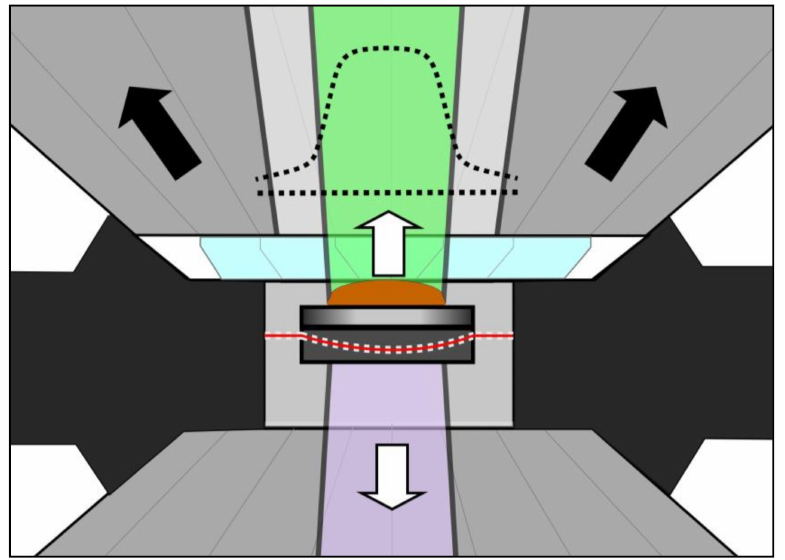
Figure 5. Schematic of dynamic compression in an LDC–DAC with internal target (See Figure 2B), showing an impinging laser beam (green) on a target (graded plate). The target is partially ablated, resulting in a plasma plume (orange dome), with a shock (or impulse) passing through the sample (hashed lines). Heat transfer occurs initially through radiation from the plasma (black arrows). A Reflected wave eventually travels back toward the laser source (upward white